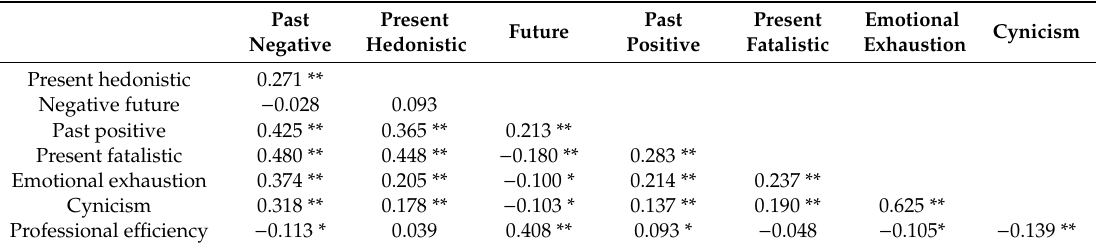
Table 2. Pearson Correlations between the studied